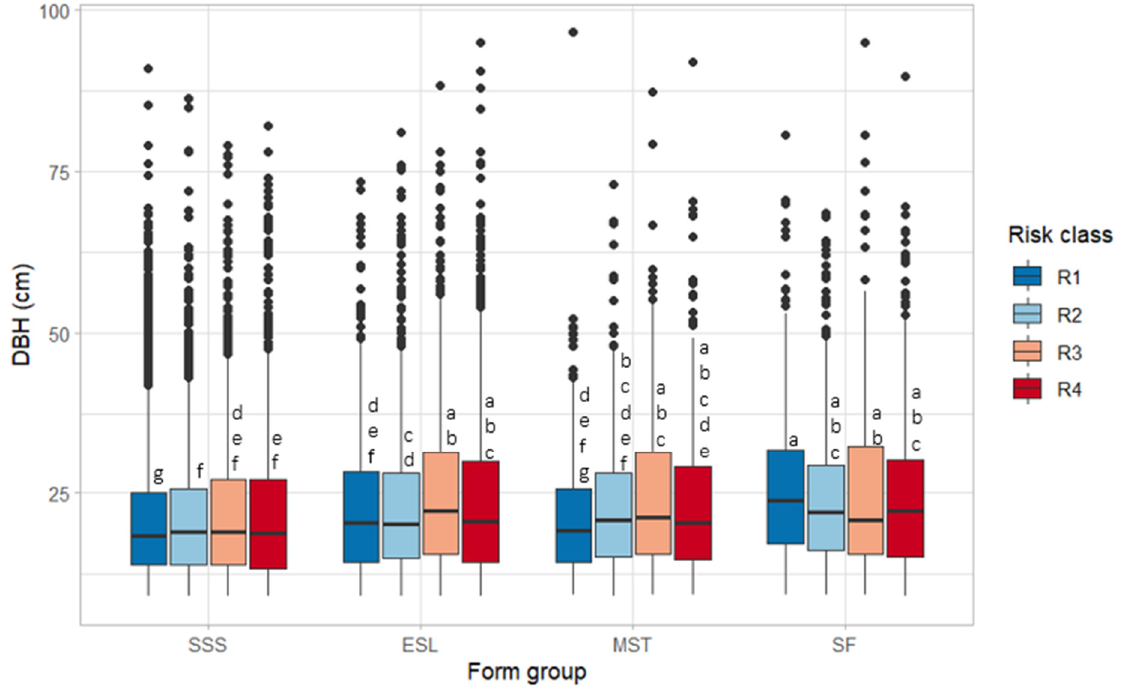
Figure 9. DBH (cm) depending on form group (SSS: single straight stem, ESL: extensive sweep or lean, MST: multiple stems, SF: significant fork) and risk class (R1–R4) (N = 25,516). Different letters indicate statistically different DBH’s between risk groups based on Tukey-HSD post hoc tests.